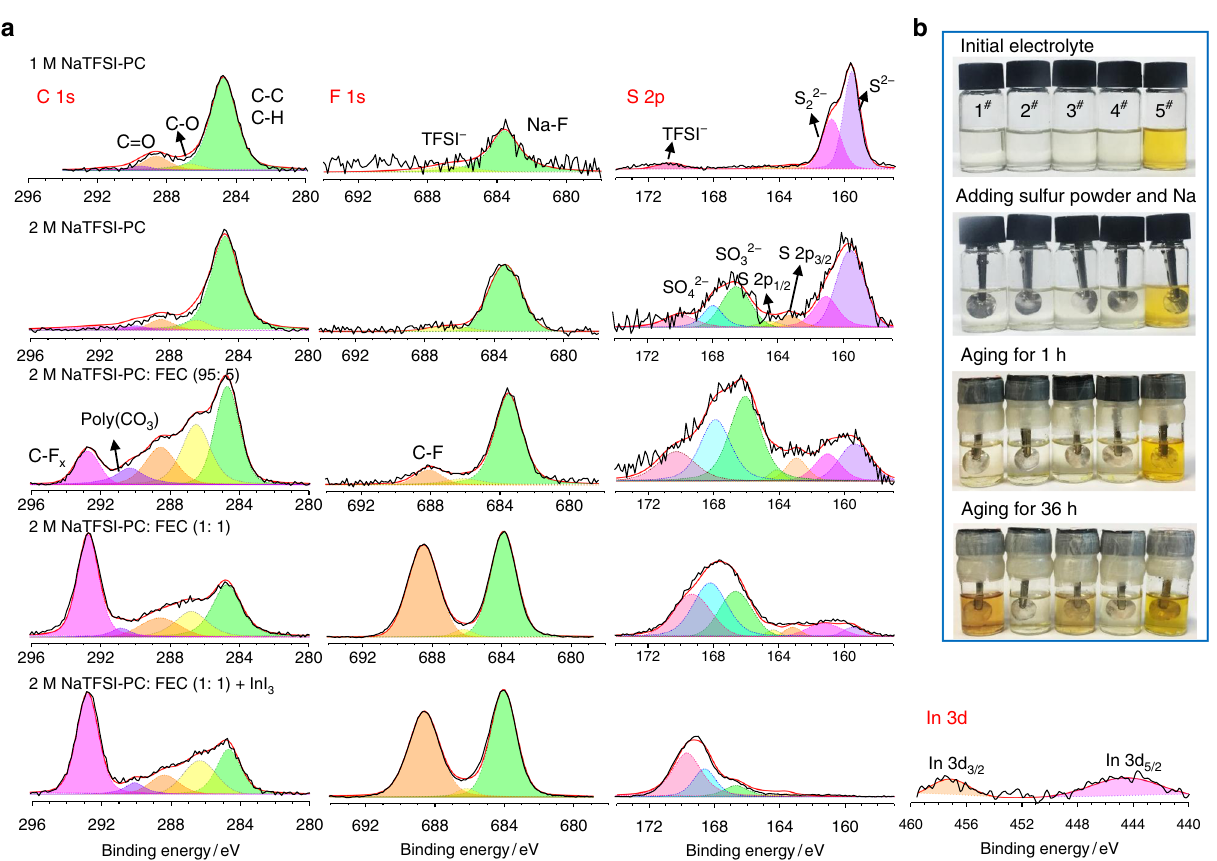
Fig. 3 Characterization of polysul fi des formation in different electrolyte systems. a XPS spectra of the Na metals from Na/S@MPCF cells using different electrolytes after 50 cycles at 0.1 C; b Visual observation of Na polysul fi des formation in fi ve electrolyte samples (1#:1 M NaTFSI in PC; 2#: 1 M NaTFSI in PC: FEC (1:1 by volume); 3#: 2 M NaTFSI in PC; 4#: 2 M NaTFSI in PC: FEC (1:1 by volume); 5#: 2 M NaTFSI in PC: FEC (1:1 by volume) with 10 mM InI 3 ) along with aging time at 60 °C, The same amounts of sulfur (5 mg) and Na metal foils were added into the electrolytes to simulate the